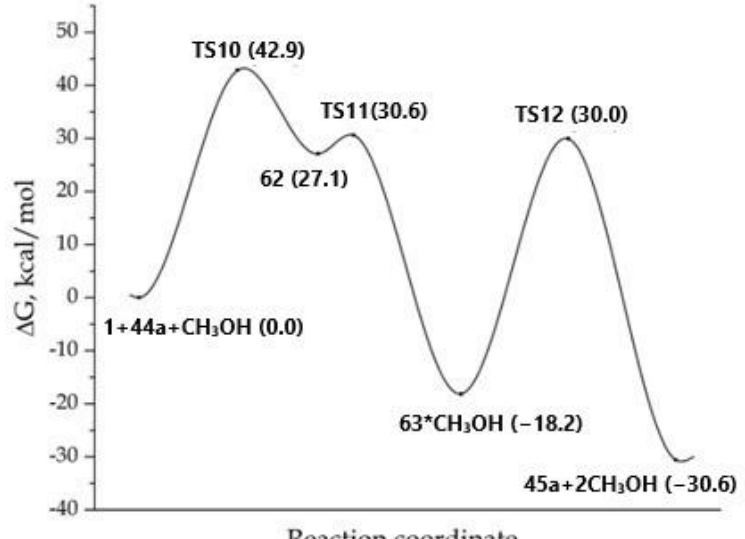
Scheme 13. Proposed trimolecular formation mechanism of 45a .